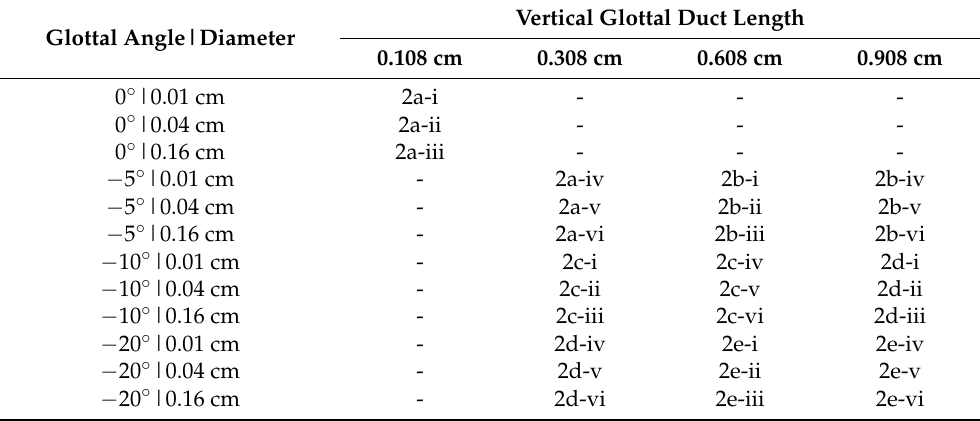
Table 2. Location of specific glottal configurations (glottal angle, minimal glottal diameter, and vertical glottal duct length) and the corresponding intraglottal pressure distributions in Figure